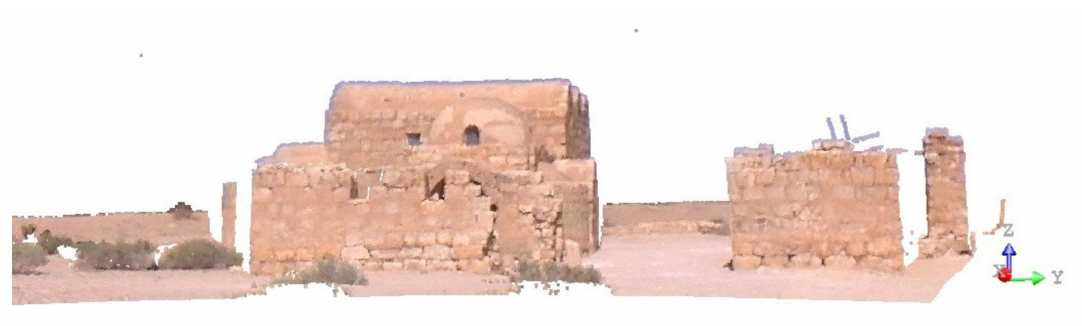
Figure 8. Images captured using the camera installed on the Terrestrial Laser Scanner (TLS) device.